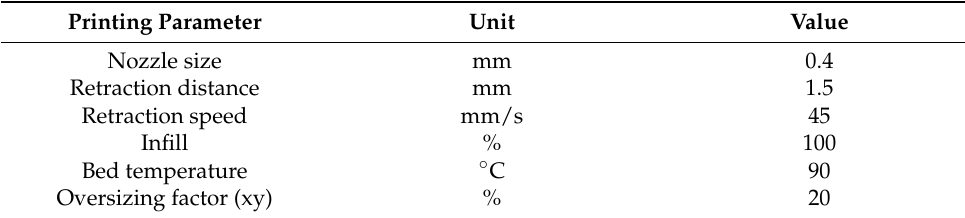
Table 1. Common printing settings for the Ultrafuse